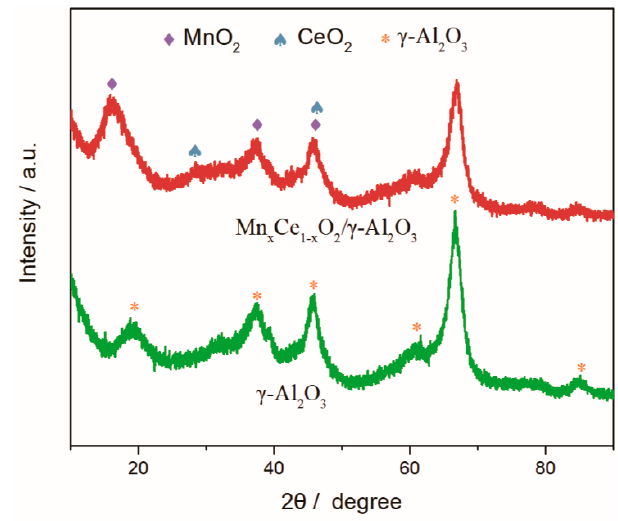
Figure 3. XRD patterns of γ -Al 2 O 3 and Mn x Ce 1-x O 2 / γ -Al 2 O 3 .